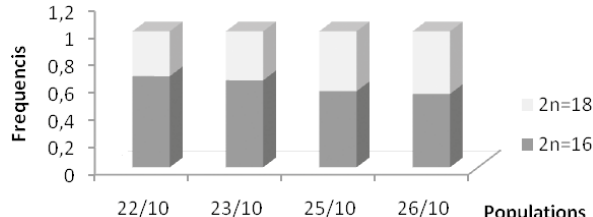
Figure 2. Frequencies of the two chromosomes numbers (2n=16 and 18) in the four populations of Trifolium subterraneum L. (15 individuals / population).